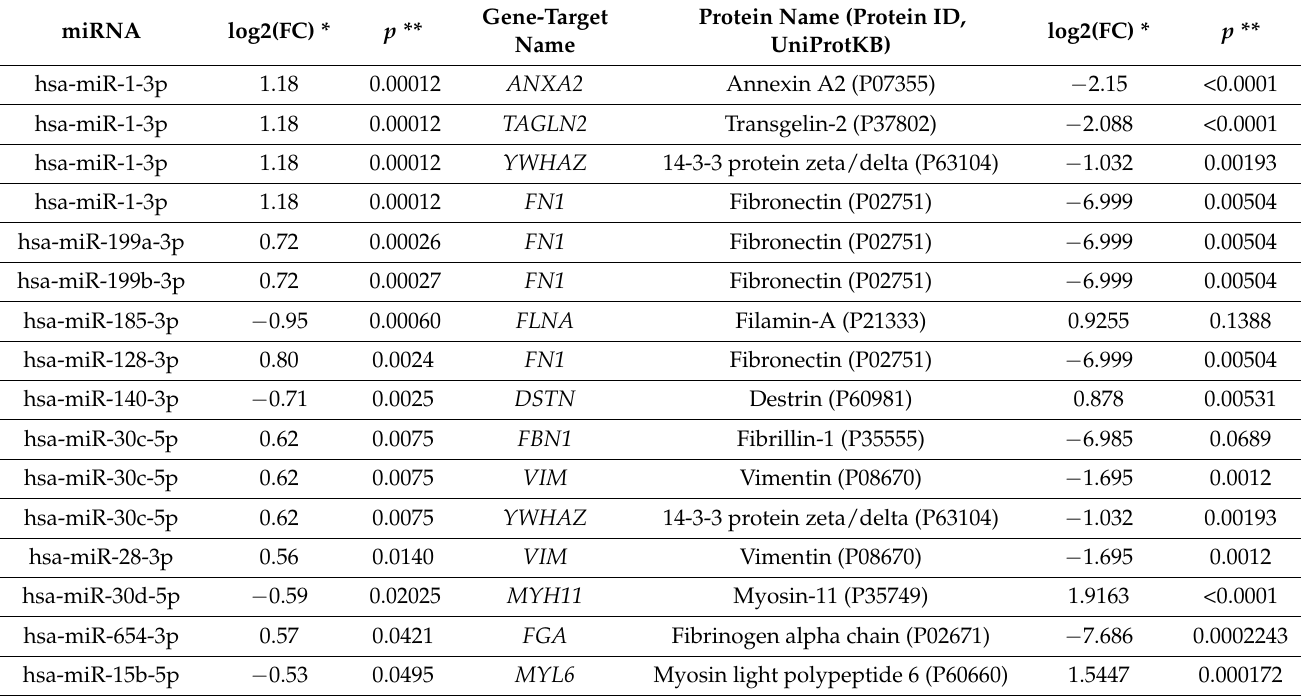
Table 2. miRNAs and their target genes, differentially expressed in the placental bed samples from women with IUGR < 34 according to the data of miRNA deep sequencing and mass